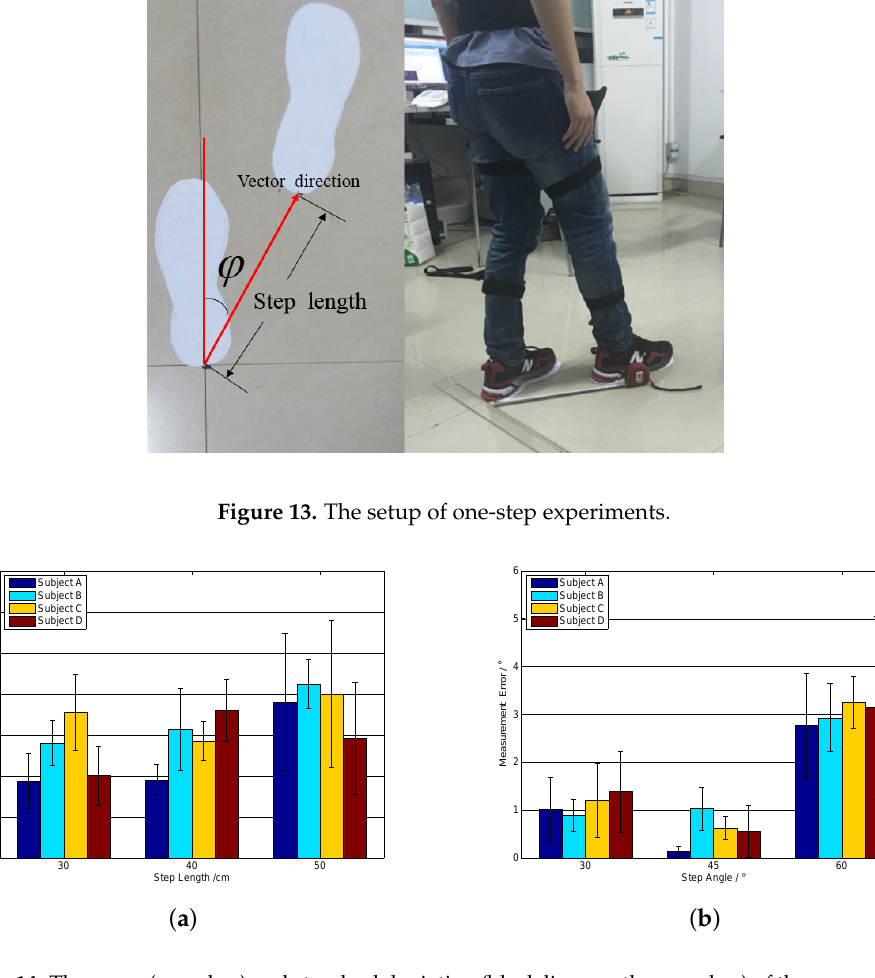
Figure 14. The mean (error bar) and standard deviation (black lines on the error bar) of the measurement error per subject according to the step length and step angle. ( a ) The measurement error per subject according to the step length; ( b ) The measurement per subject according to the step